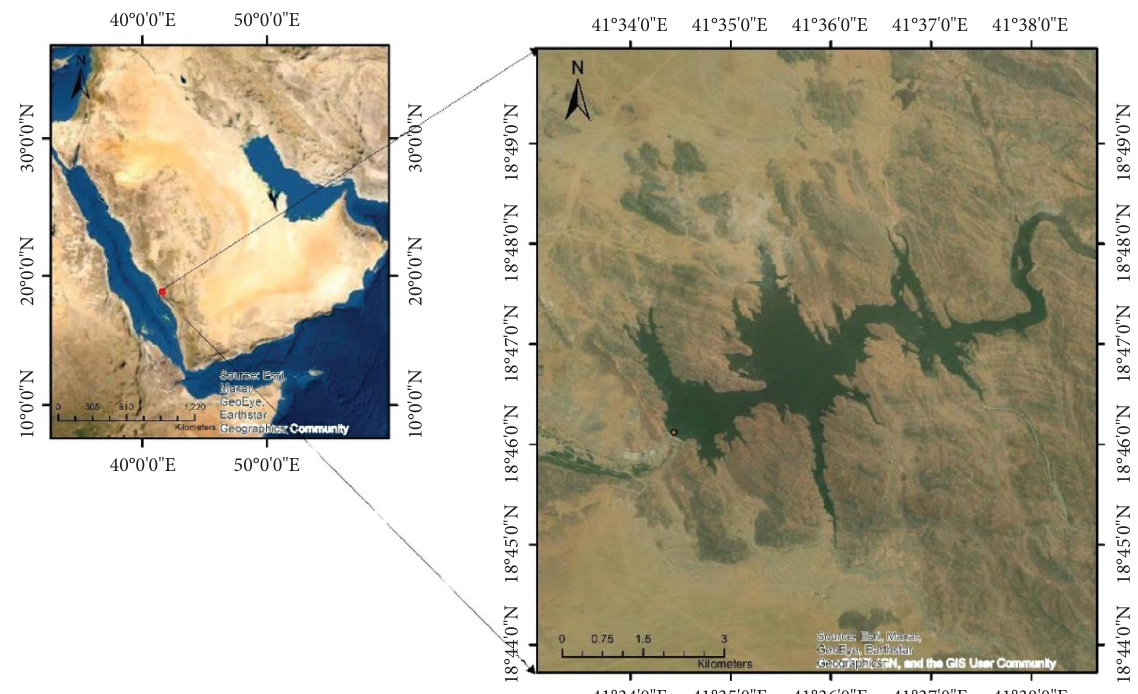
Figure 1: Hali Dam, Saudi Arabia [18 ° 46 ′ 4.30 ″ N 41 ° 34 ′ 28.29 ″ E].